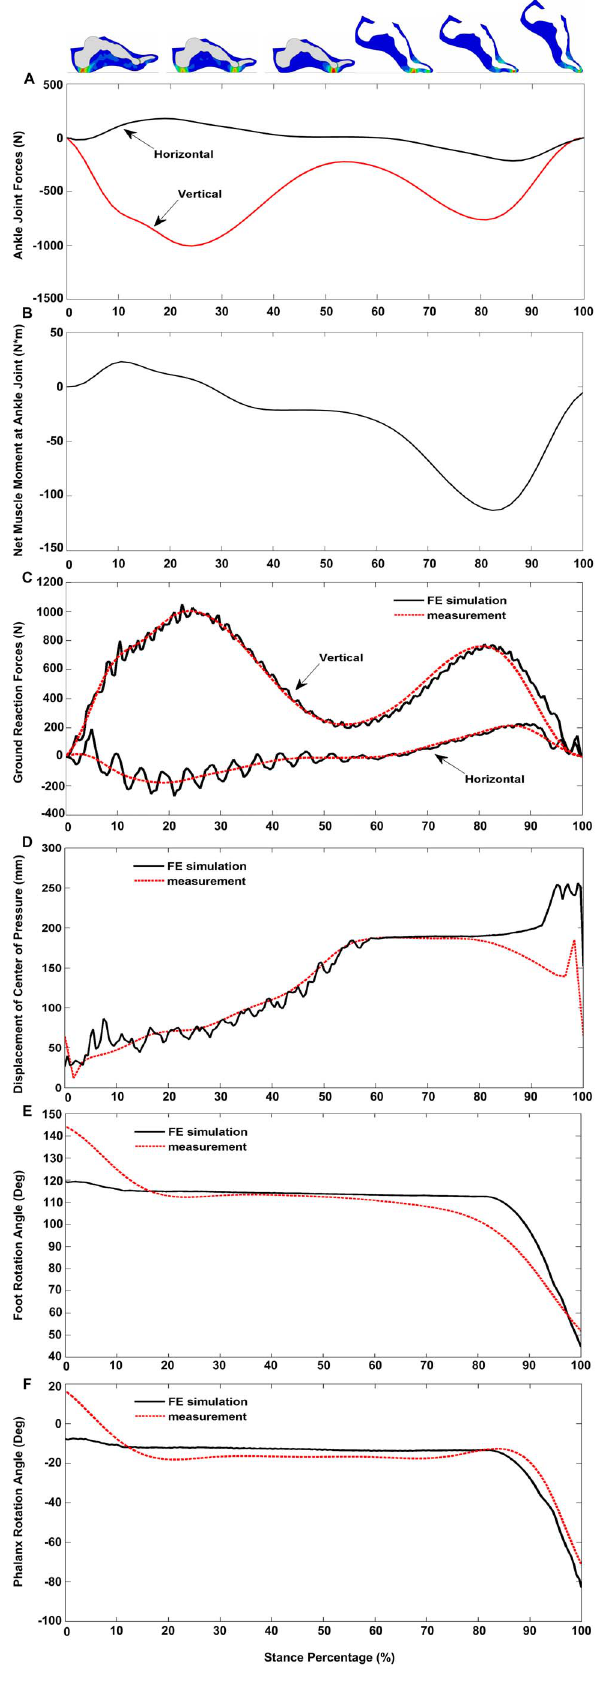
Figure 3. The FE model inputs and the FE simulation results over the whole stance phase compared with the measurement data. (A) Ankle joint force inputs. (B) Ankle moment input. (C, D, E and F) The FE simulation results compared with the measurement